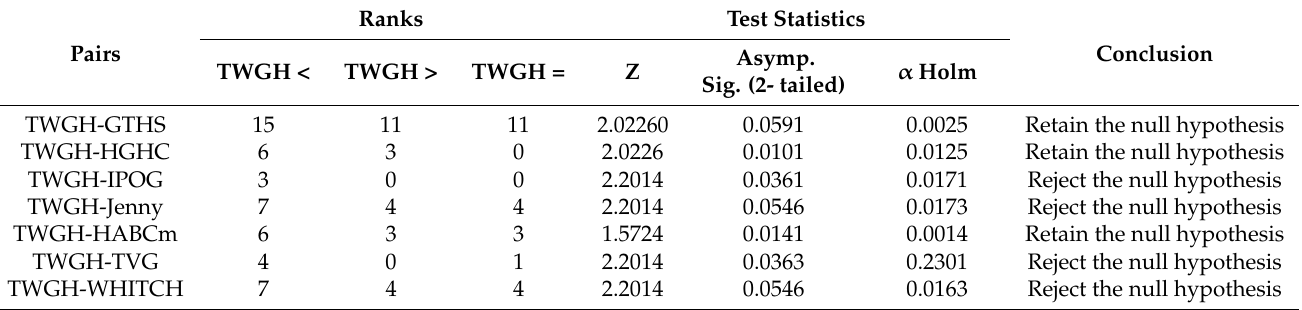
Table 7. Analysis of data from Table 3 using the Wilcoxon signed-rank sum test.